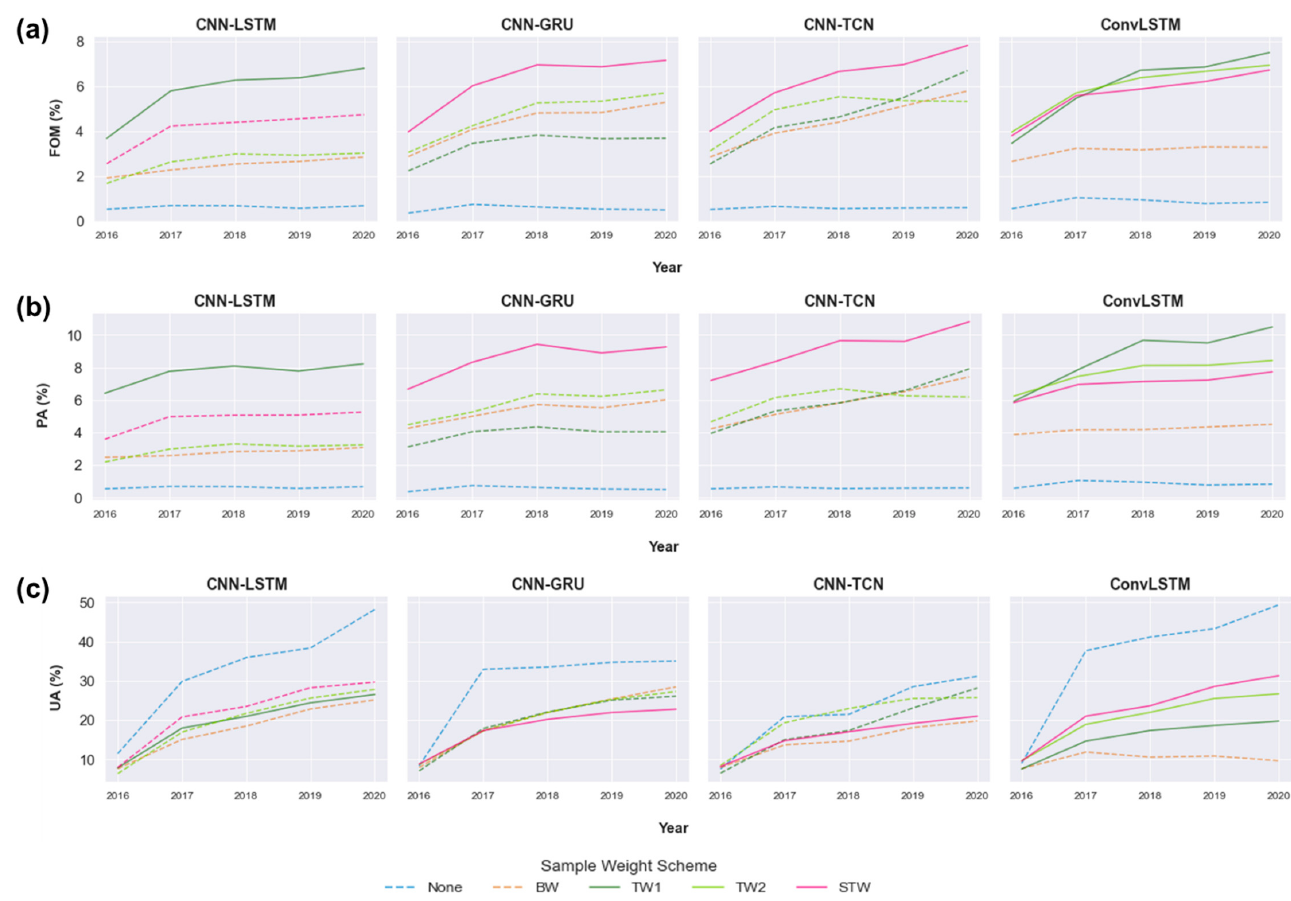
Figure 5. Values obtained for each model type and sample weight combination with respect to cumulative changes from 2016 to 2020 with measures: ( a ) figure of merit (FOM), ( b ) producer’s accuracy (PA), and ( c ) user’s accuracy (UA). The model and sample weight combinations with the top six FOM values are indicated by bold lines.